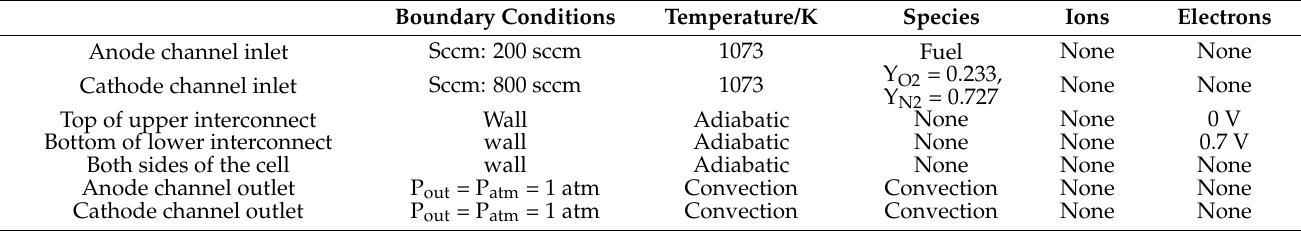
Table 6. Boundary conditions of SOFC model.